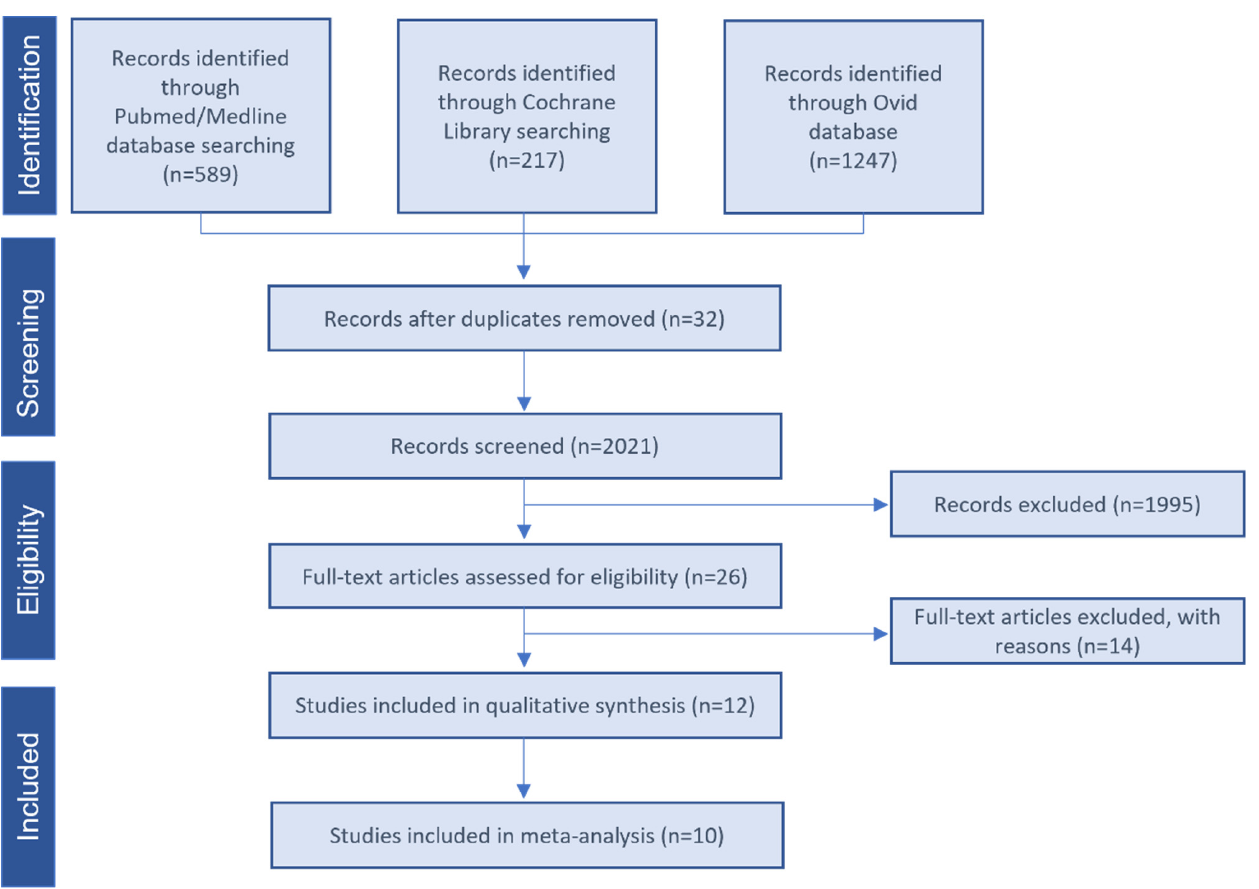
Figure 1. Study selection flow diagram. PRISMA flow diagram of the screening and selection process.